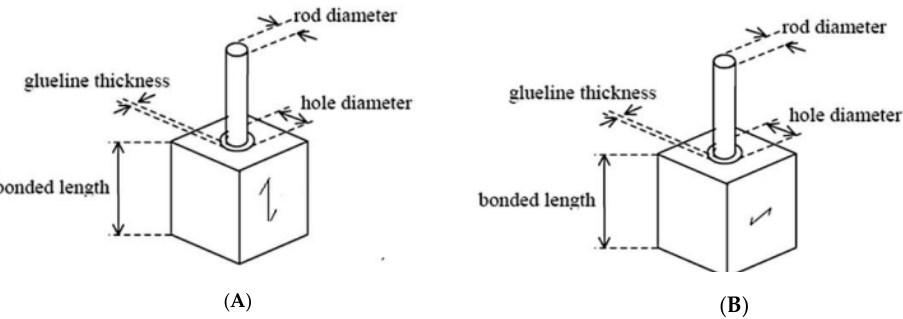
Figure 1. Specification of Glulam Block for Pull-Out Strength Test; ( A ) Parallel (PR0 ◦ ) and ( B ) Perpendicular (PP90 ◦ ).